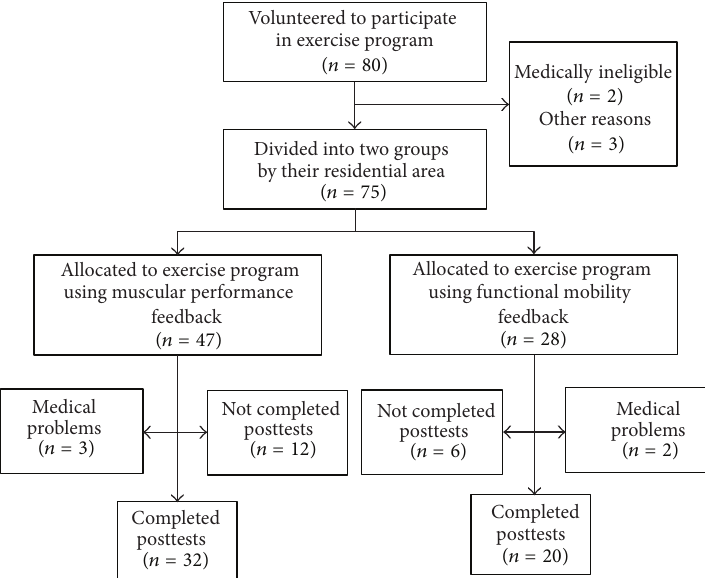
Figure 1: Flowchart tracking participants throughout the